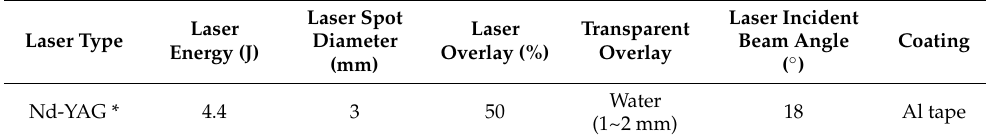
Table 4. Conditions of laser shock peening treatment (Reprinted with permission from [36]. 2022,